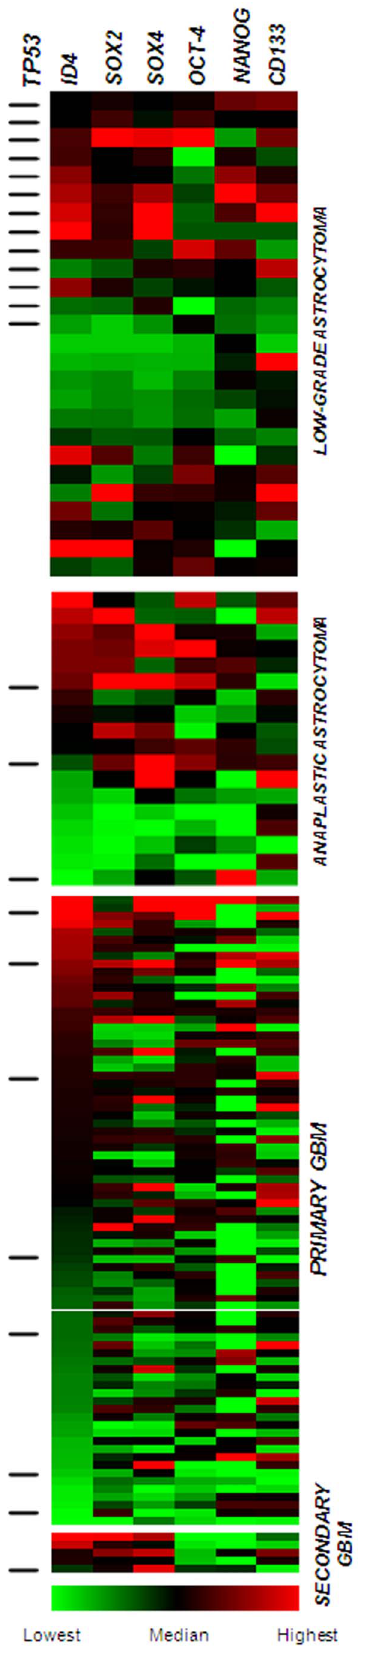
Figure 5. Heatmap displaying the relative gene expressions in low-grade astrocytoma (AGII), anaplastic astrocytoma (AGIII) and GBM cases according to TP53 mutation status. The TP53 mutated cases are represented by side dashes. The mutated TP53 AGII cases showed more elevated expression levels of ID4 , SOX2 , SOX4 and NANOG . CD133 expressions were more heterogeneous among the cases. SOX2 and SOX4 showed similar expression levels to ID4 . Similarly, secondary GBM cases also presented higher ID4 , SOX2 , SOX4 expression levels. OCT-4 , NANOG and CD133 expression levels were heterogeneous among secondary GBM cases, and OCT-4 presented higher mRNA levels